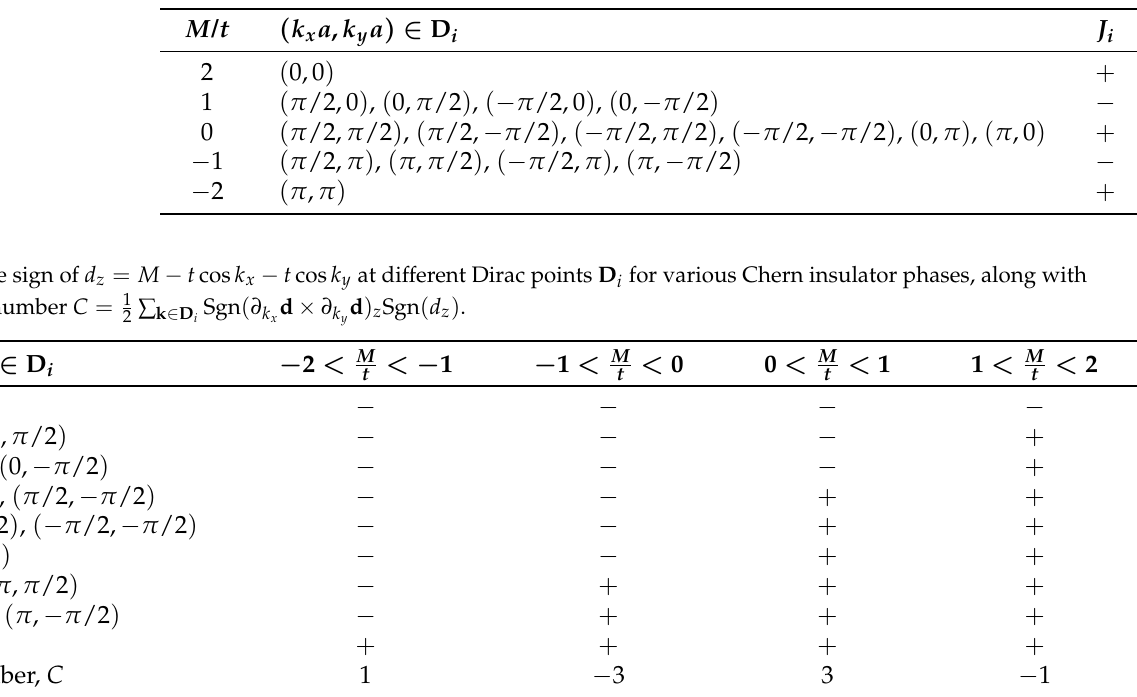
Figure 4. The first Brillouin zone for a Chern insulator described by Equation (35), showing the Dirac points enclosed. Dirac points with positive (negative) chirality are colored blue (ochre); cf. Table 1. Table 1. Dirac points D i for different values of M / t , and the corresponding chiralities J i .